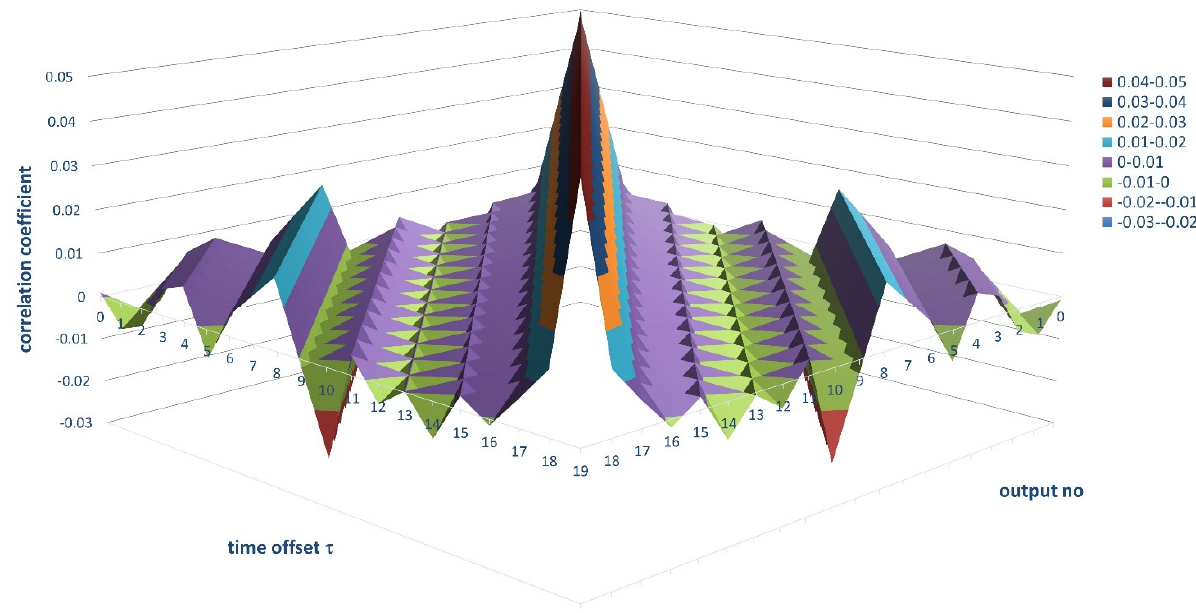
Figure 5. The graph for the correlation coefficient for an example of the type I LFSR register shown in Figure 3a—the zoomed-in picture for the correlation coefficient ranging from − 0.03 to +0.05. The correlation coefficient was calculated for the test sequence with the length of 10,000 vectors.